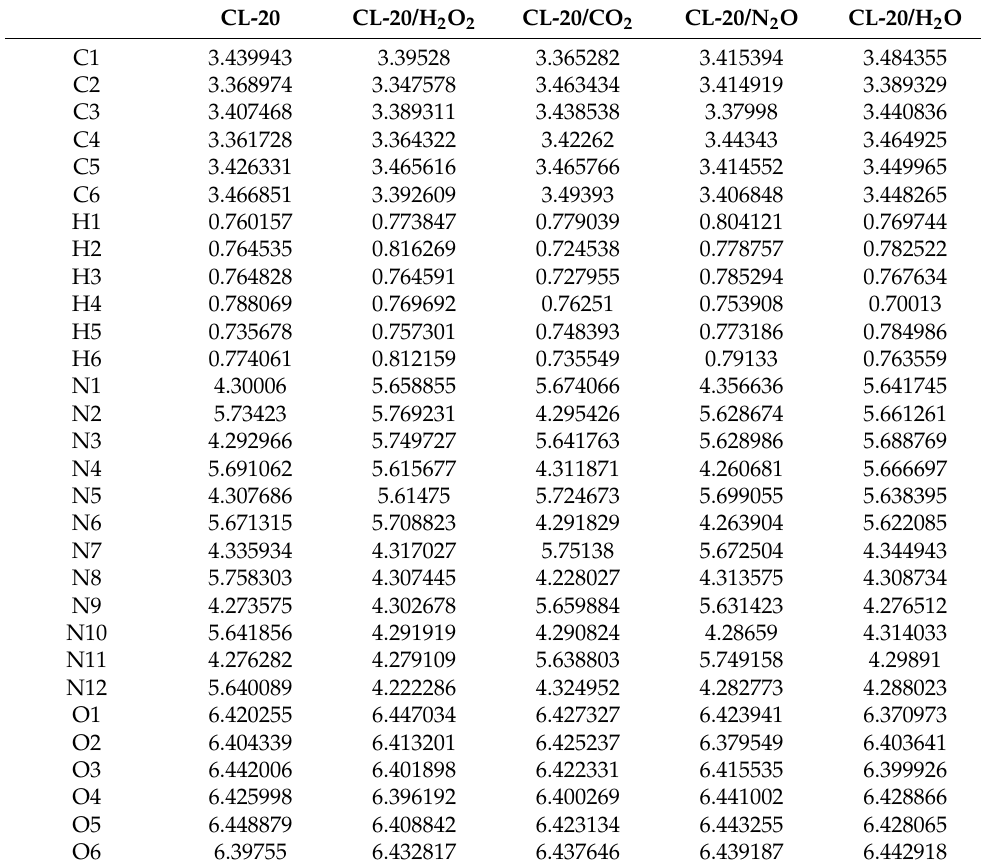
Figure 13. The electric charge density of CL-20 and its complexes: ( a ) CL-20, ( b ) CL-20/H 2 O 2 , ( c ) CL-20/CO 2 , ( d ) CL-20/N 2 O, and ( e ) CL-20/H 2 O, respectively. Table 2. The charge of all atoms for CL-20 and its complexes.